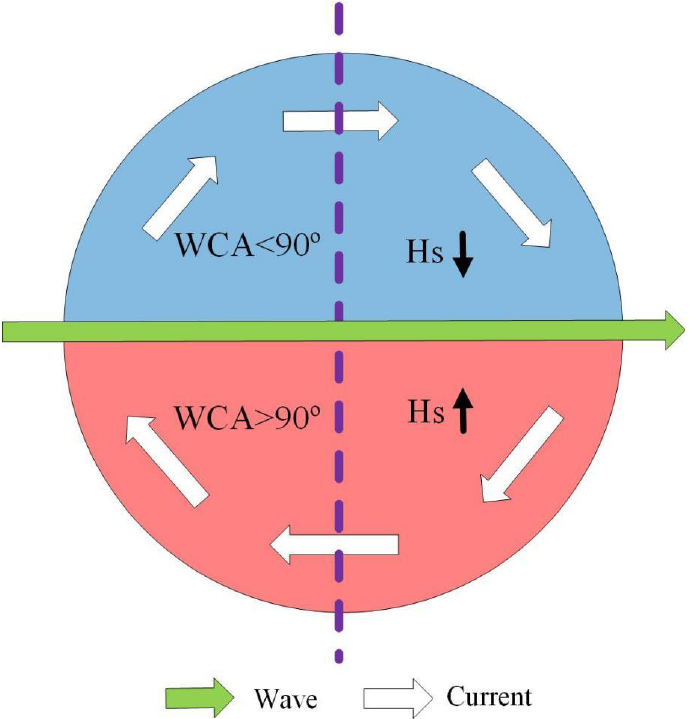
Figure 13. The schematic diagram of anticyclonic eddy influence sea surface waves. Blue represents decrease and red represents increase. The green arrow represents wave direction. The white arrow represents current direction. The purple track represents the best wave track selected to study the CEW.